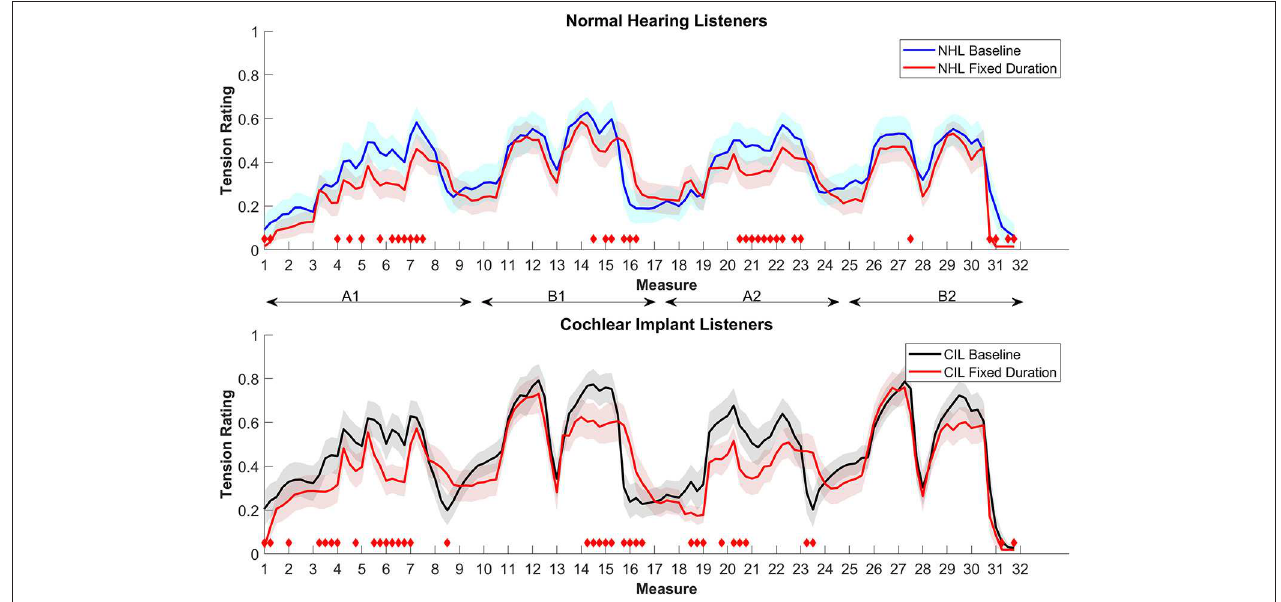
FIGURE 4 | Average tension ratings of 9 NHL (top panel) and 8 CIL (bottom panel) for the baseline and condition 4, fixed duration (in red). See details in Figure 1 .